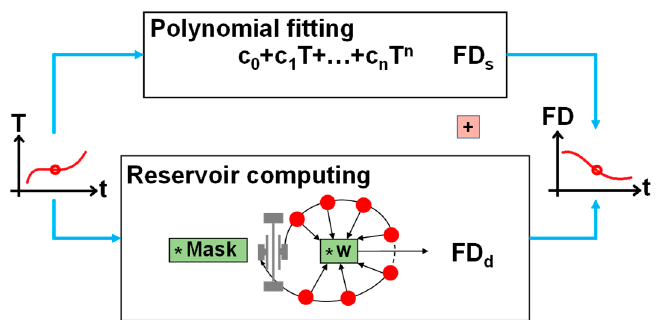
Figure 3. The flow chart of the temperature compensation method. Measured temperature T is sent to polynomial and reservoir simultaneously. The polynomial fitting yields FD s and the reservoir computing predicts the FD d . The total estimated FD is the sum of FD s and FD d .